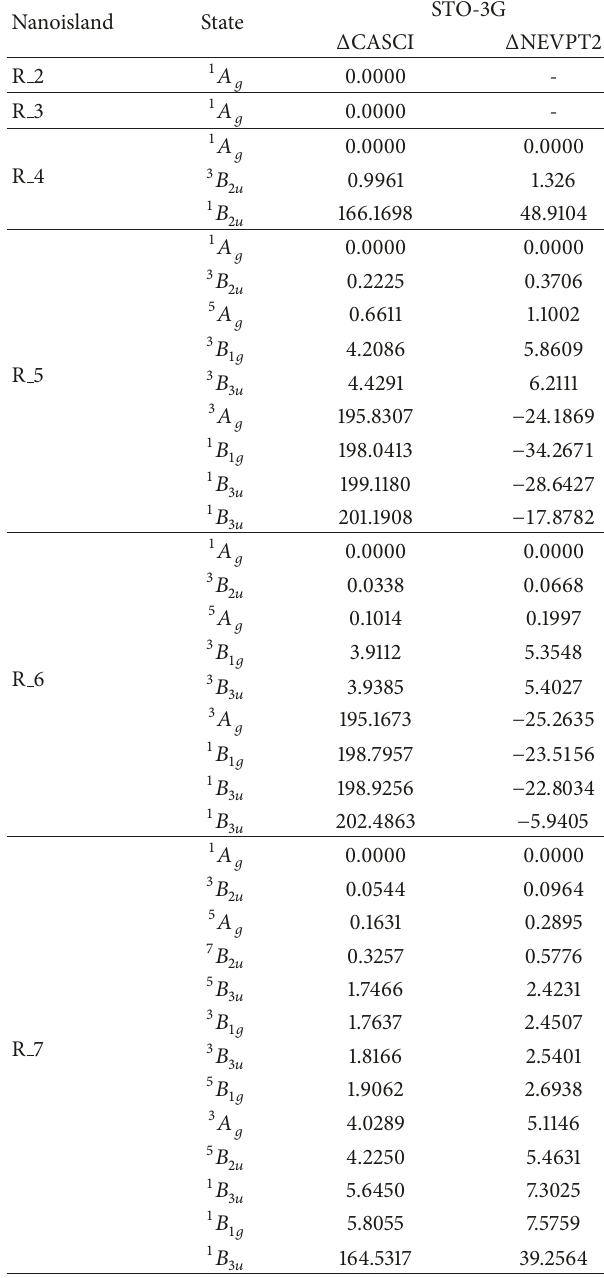
Table 7: Energies for the different rhombus nanoislands in hartree. Nanoisland